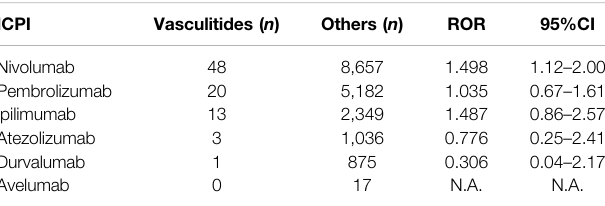
TABLE 5 | Reporting odds ratios for vasculitides. ICPI Vasculitides ( n ) Others ( n ) ROR 95%CI